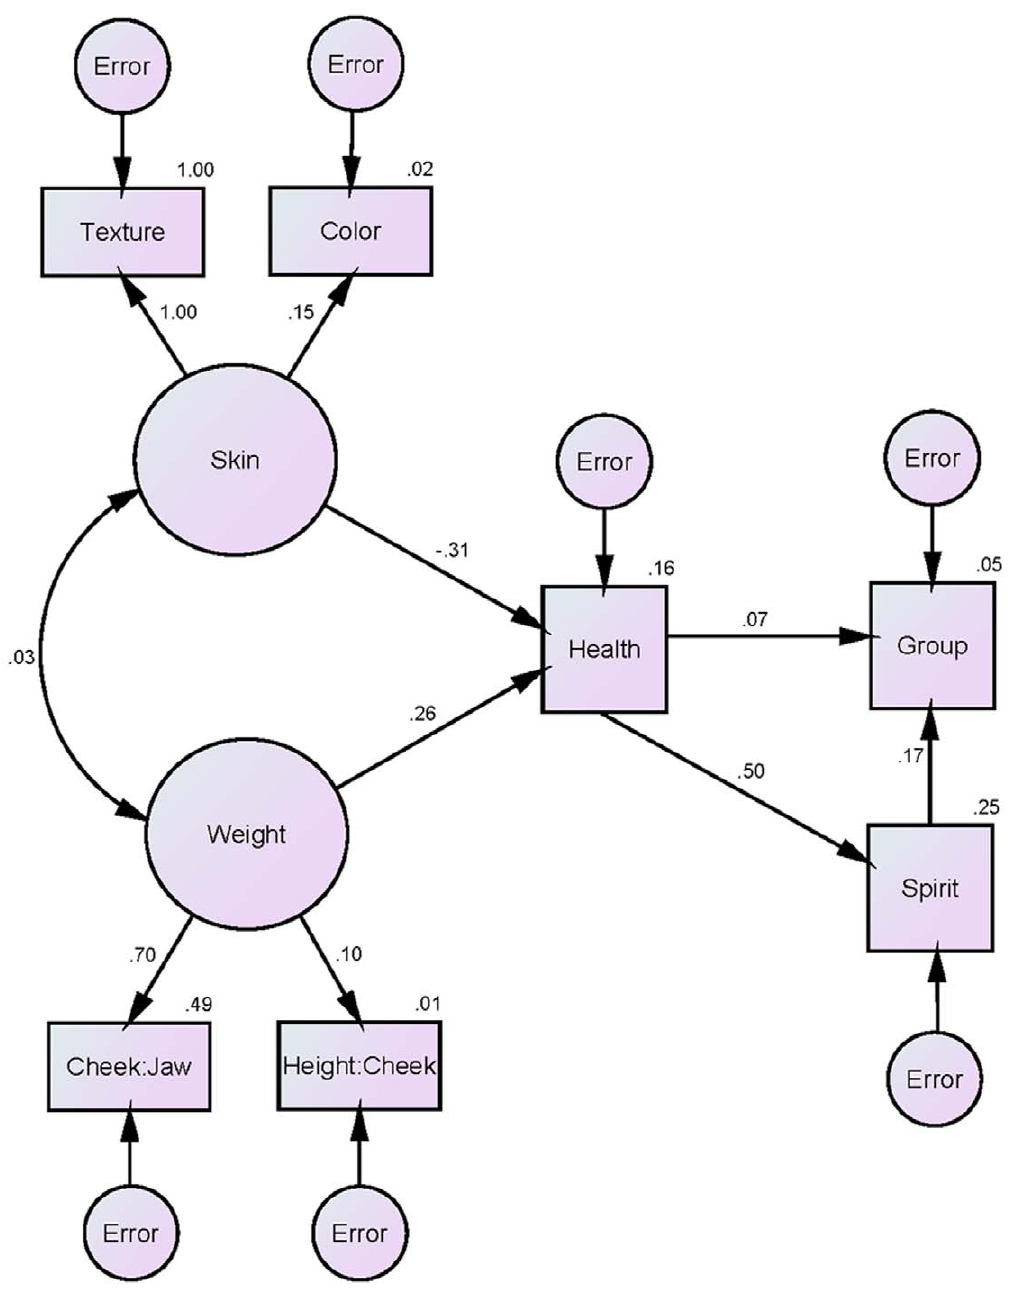
Figure 3. Structural equation model testing the contributions of factors related to skin quality and weight to predicting targets’ Mormon and non-Mormon group membership and perceptions of spirituality from their faces, via perceptions of health. Path coefficients are standardized ( b ’s), error variances for the endogenous variables are indicated in ovals, and variances explained (multiple R 2 values) are adjacent to the endogenous